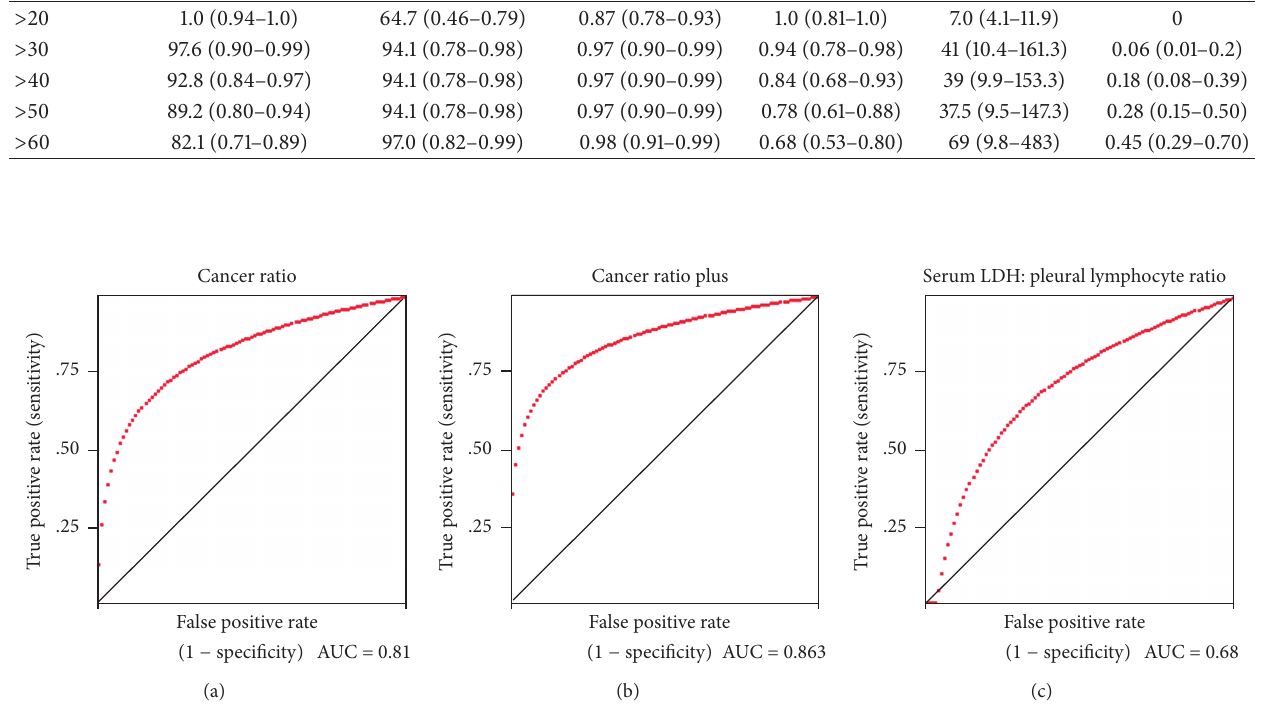
Figure 1: (a) ROC curve for various cut-off levels of cancer ratio in differentiating between malignant pleural effusions from TB pleural effusion. AUC of 0.81 suggests good accuracy of this test. (b) ROC curve for various cut-off levels of cancer ratio plus (cancer ratio:pleural fluid lymphocyte count) in differentiating between malignant pleural effusion from TB pleural effusion. AUC of 0.86 suggests good accuracy of this test. (c) ROC curve for various cut-off levels of serum LDH :pleural lymphocyte count ratio in differentiating between malignant pleural effusion from TB pleural effusion. AUC of 0.68 suggests poor accuracy of this